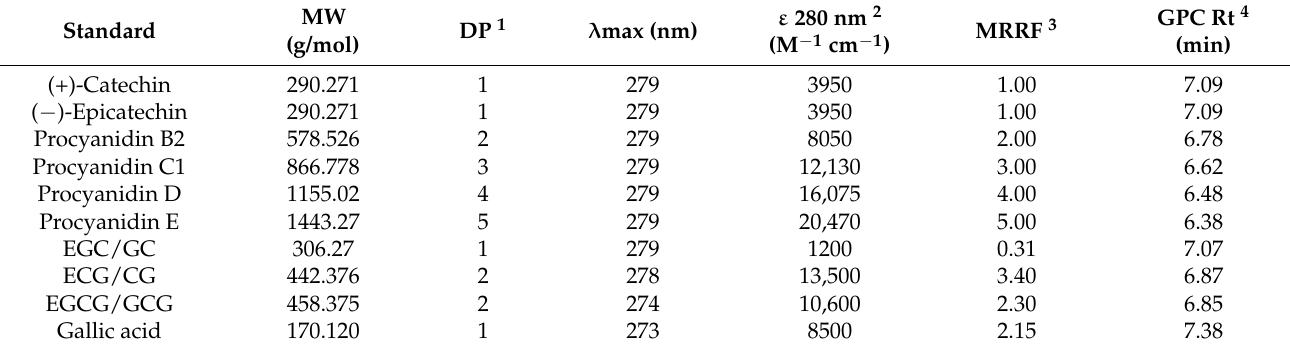
Table 1. Retention times and molar extinction coefficient of PAC standards analyzed by